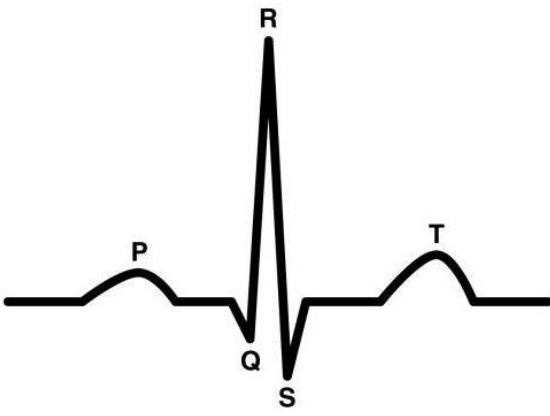
Figure 3. QRS complex of an ECG curve.